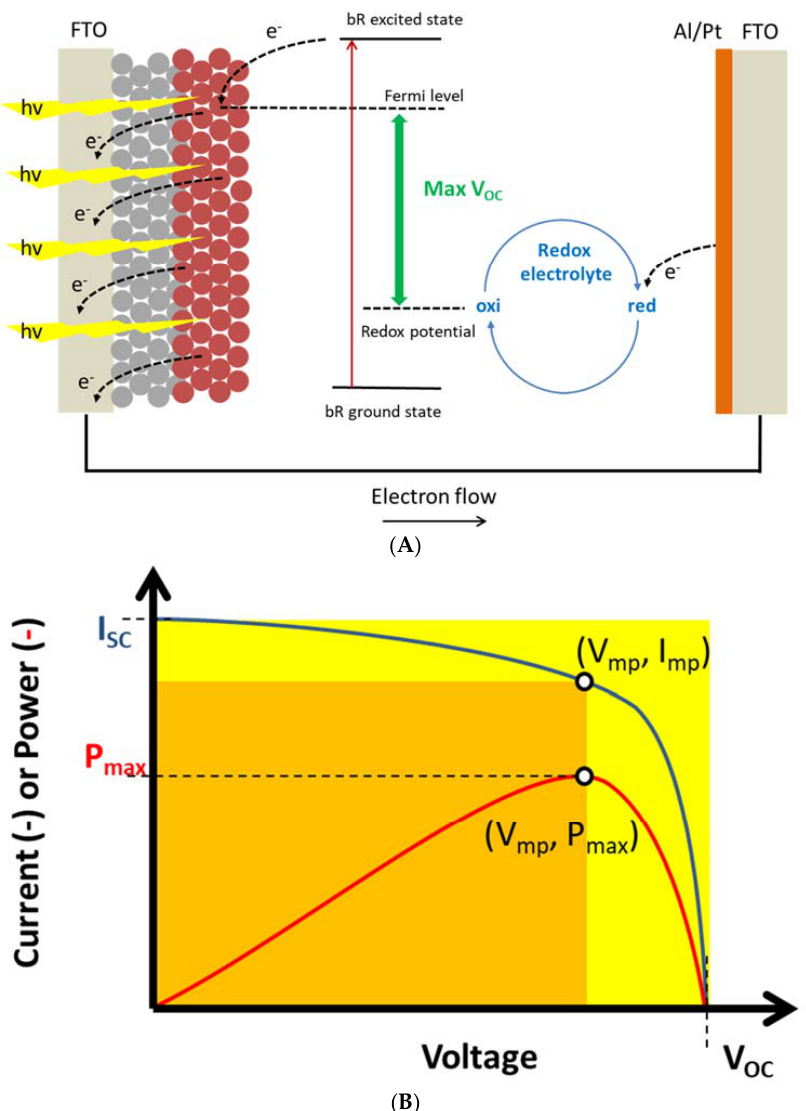
Figure 2. ( A ) Principal diagram of BSSC based on bR/purple membranes immobilized on TiO 2 spheres (red) which are deposited on a fluorine-doped tin oxide (FTO) conducting glass. This acts as the working electrode with an FTO surface covered with aluminium (Al) or platinum (Pt) as counter electrode. A redox electrolyte (e.g., based on I − /I 2 − ) is encapsulated between the FTO slides. The photon induced photocurrents arises from excitation of bR leading to electrons being injected into the FTO working electrode. The maximal output (V OC ) is determined by the difference between the Fermi level and redox level. ( B ) Photo-current/photo-voltage (I/V) relation. V OC : open circuit voltage; I SC : short circuit current (at V OC = 0). V MP : voltage at maximal power output P MAX . I MP current at P MAX . The ratio between the yellow area and orange area defines the fill factor (FF), see also Table